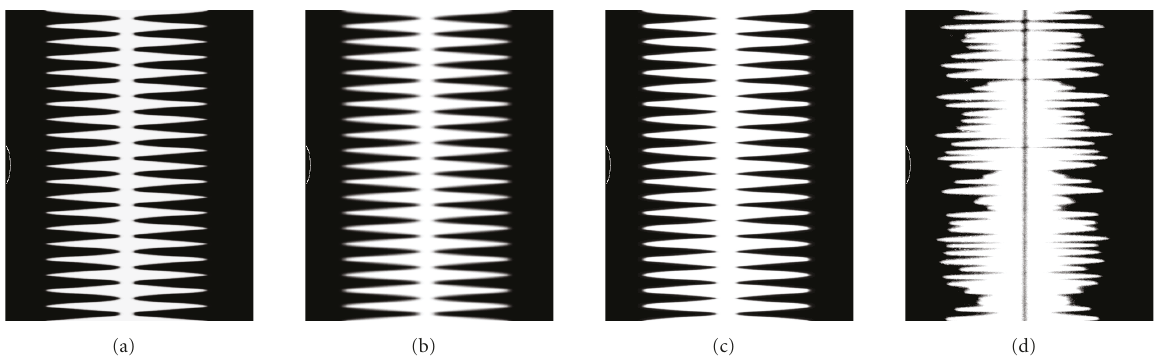
Figure 8: Test tone underexposed (a), correctly exposed (b), overexposed (c), and a real sound showing underexposure (d).